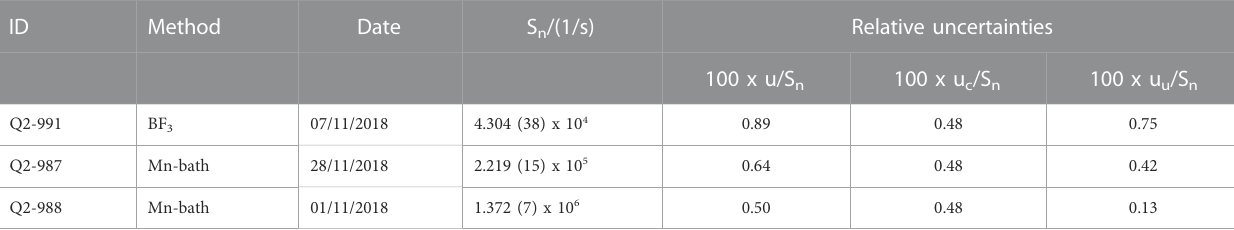
TABLE 8 Neutron emission rate (S n ) of the 252 Cf(sf) neutron sources that were certi fi ed for their emission rate at NPL. The total uncertainty (u) together with the correlated (u c ) and uncorrelated (u u ) components are given.